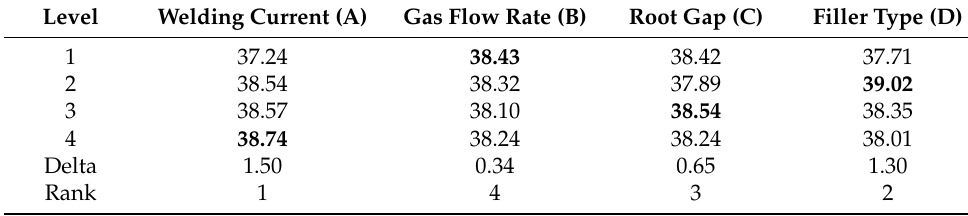
Table 13. Response table for signal-to-noise ratios for Hardness (larger is